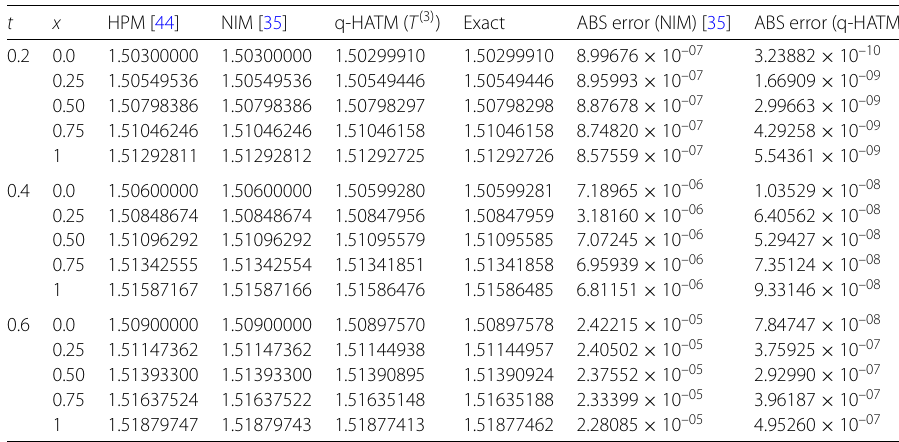
Table 5 The comparison of numerical result of T ( x , t ) obtained by NIM [35], HPM [44], q-HATM, and the exact solution Equation (32), also the absolute (ABS) errors when α = 1, (cid:2) = –1, k = η = 0.1, p = 1.5, r = –1.5, and n = 1 for Example